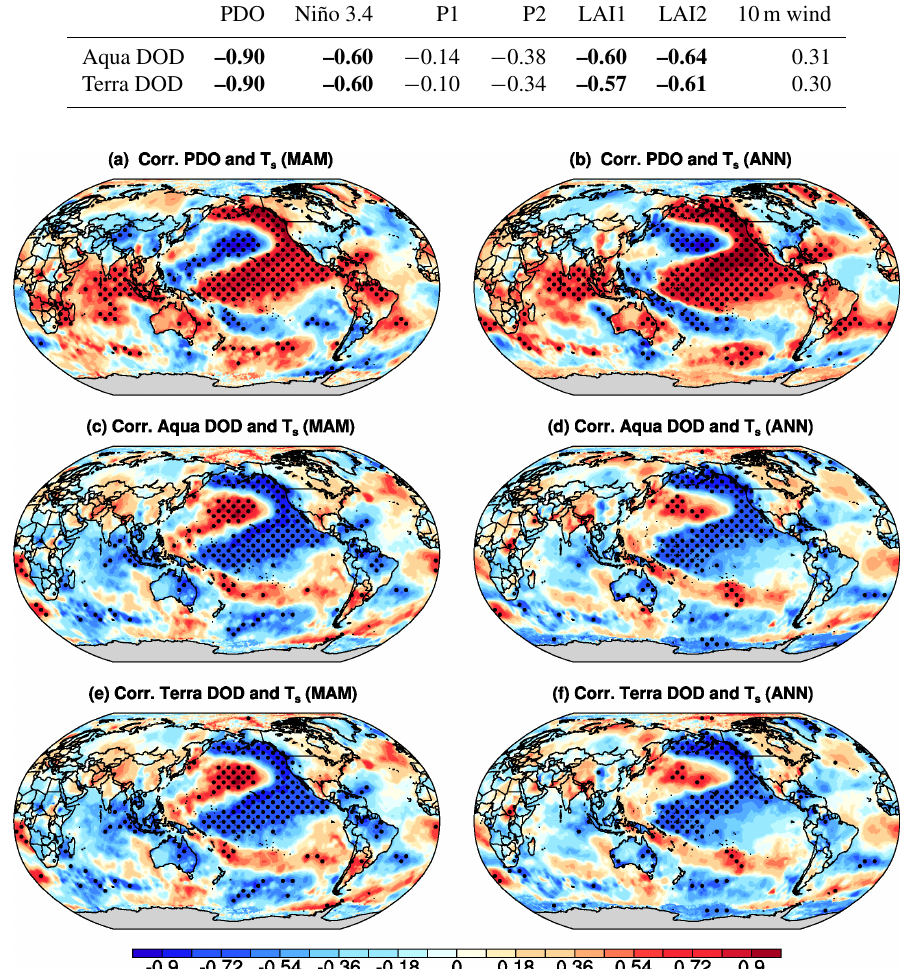
Figure 3. Correlation between the PDO index and HadISST (over the ocean) and CRU TS3.23 near-surface temperature (over land) for (a) MAM and (b) annual mean during 2003–2014. Correlation between (c) – (d) Aqua and (e) – (f) Terra DOD indices, and HadISST and CRU near-surface temperature for (c) , (e) MAM and (d) , (f) annual mean during 2003–2014. Areas significant at the 95% confidence level ( t test) are